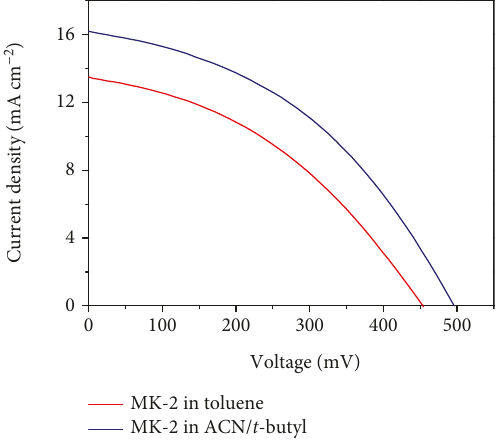
Figure 5: Red and blue lines correspond to the I - V characteristics of fi lms dyed using 0.3mM of MK-2 the DSSCs with 15 μ m thick TiO 2 in acetonitrile/ t -butyl (1 : 1 v / v ratio) and 0.3mM of MK-2 in toluene, respectively (active cell area 0.25cm 2 and measured under simulated 100mWcm -2 AM 1.5